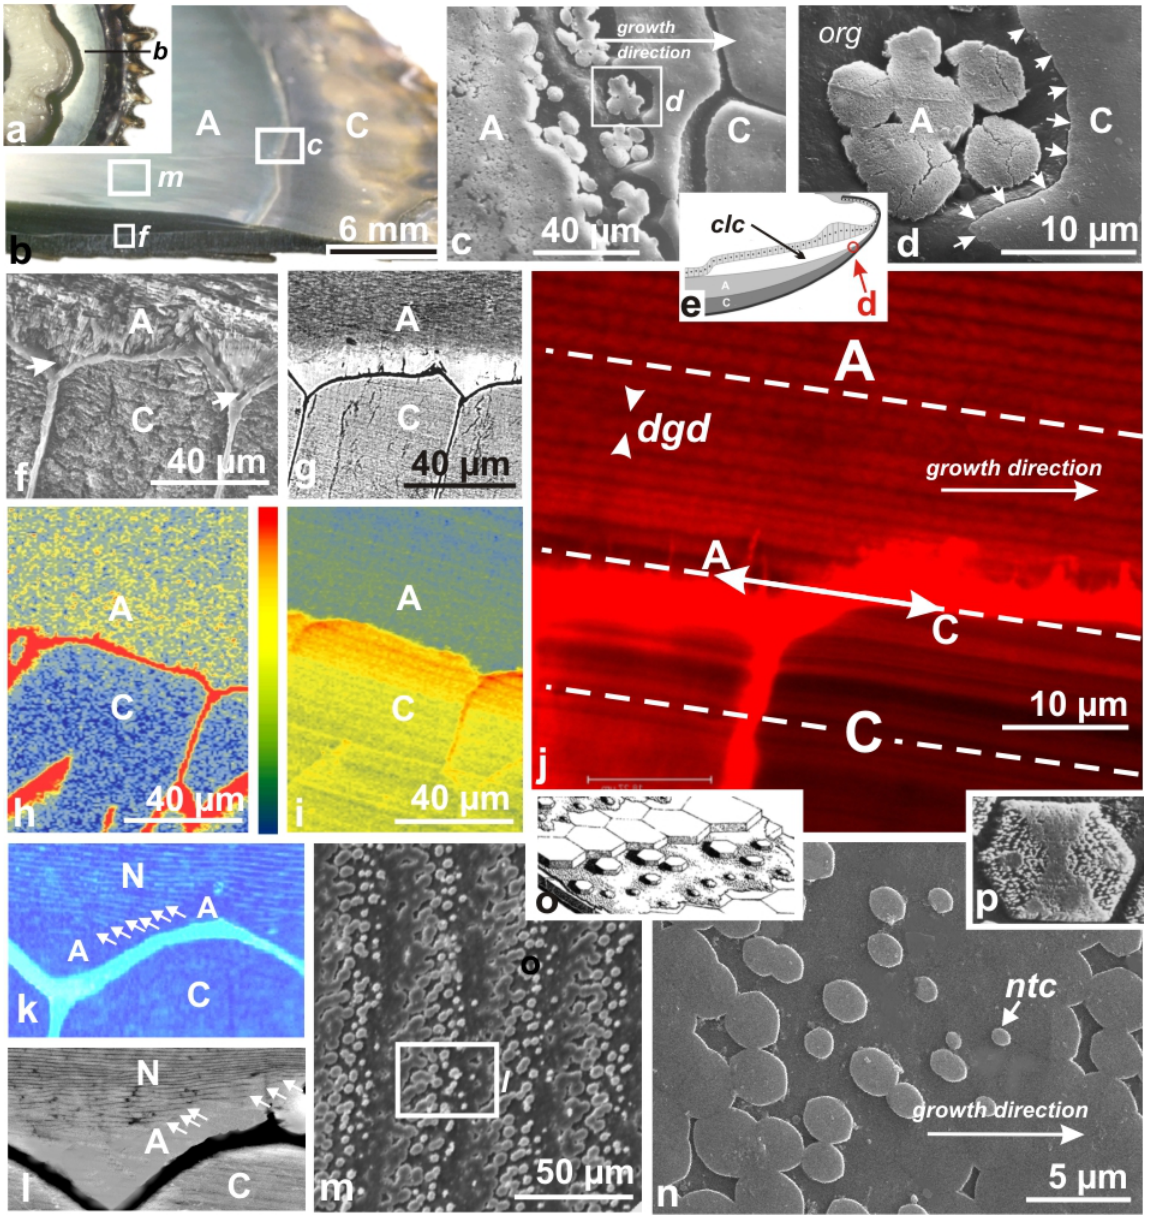
Figure 4. Structural evidence for an overall control on the growth of coral fibers. ( a – d ) From skeleton morphology to fiber fan-systems in skeleton of a coral Porites ; ( e , f ) Ultra-thin section of fan systems (cross-nicol polarized light) and etching of the same surface: continuity of growth layers emphasizes the common stepping growth mode for neighbor fibers. Note the regular thickness in deposition of a given growth layer whatever the crystallographic orientation of the substrate; ( g – i ) A polished and etched surface in the skeleton of a Pavona coral shows that the stepping growth is fully coordinated at the septum level: perfect continuity of the growth lines; ( j – l ) Similar growth-mode in the septum of a Favia corallite; ( m , n ) The specific morphology of septa in a given coral species is obtained by localized modulation of the thickness of the growth layers, as illustrated by the etched-surface of this Favia stelligera